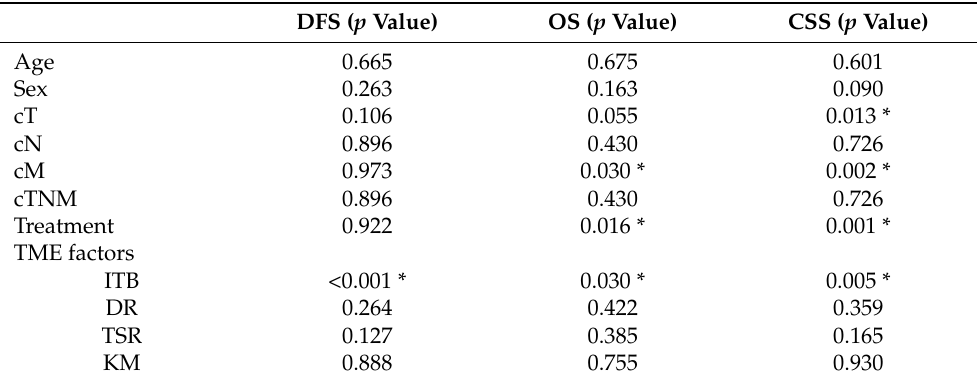
Table 2. The prognostic significances of the TME factors, such as ITB, DR, TSR, and KM grade in PBSs using the Kaplan–Meier curve analysis.